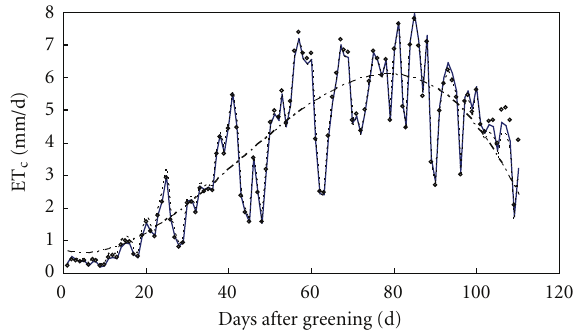
Figure 4: Original daily crop evapotranspiration (circle) and disaggregated ones with methods 1 (dash-dotted line), 2 (dashed line), and 3 (solid